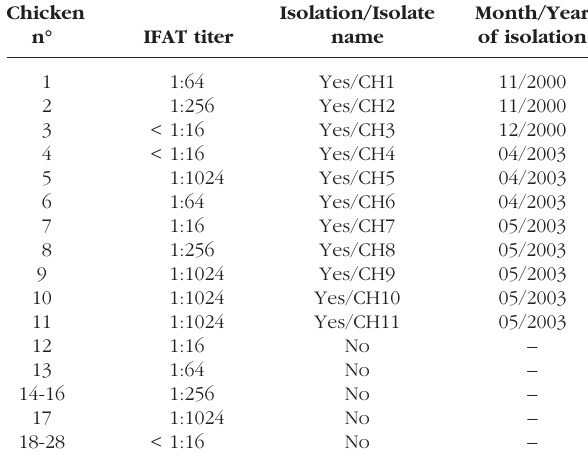
Table II. – Indirect fluorescent antibody test (IFAT) for toxoplasmosis in free range chickens sera from Minas Gerais, Brazil, and T. gondii isolates obtained from muscle